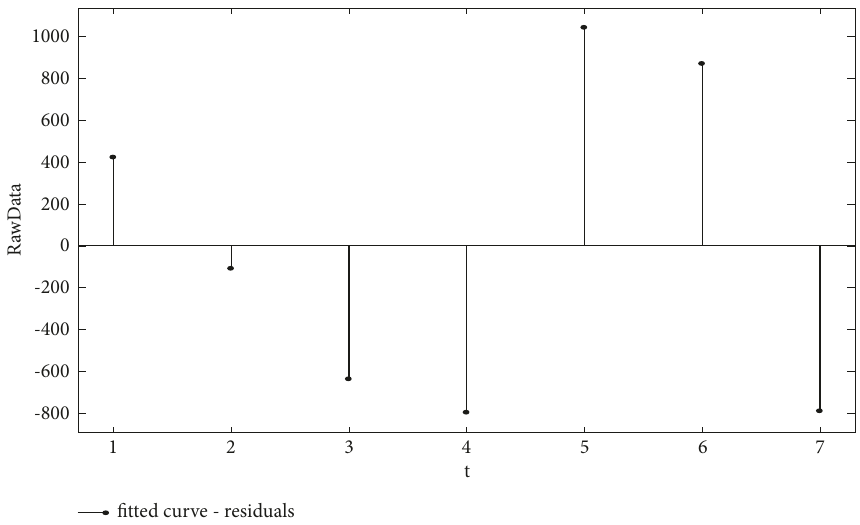
Figure 3: Residuals of the best-fitted curve. Table 1: Parameter values and description.